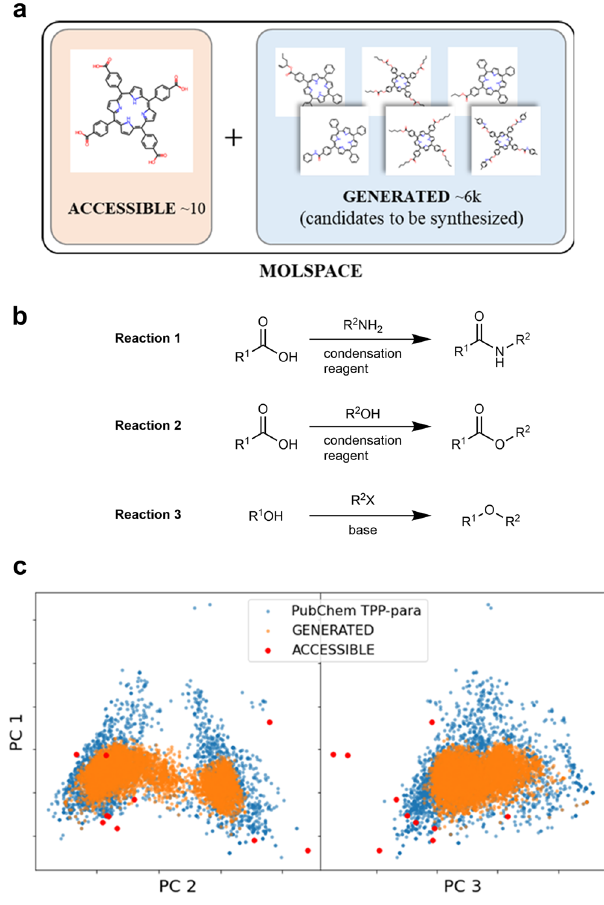
Fig. 1 Our target chemical space of TPP derivatives. a MOLSPACE contains ACCESSIBLE ( n = ~10) and GENERATED ( n = ~6k). b GENERATED molecules are generated by three simple reactions: Reaction 1; amid formation, reaction 2; esteri fi cation, and reaction 3; Williamson ether synthesis. c Mapping molecular groups over principal components (PC 1 – 3; contribution rate: 0.74) for all molecules with tetraphenylporphyrin (TPP) in PubChem. TPP-para group includes any TPP derivatives with at least one para-substitution to any phenyl group referred from